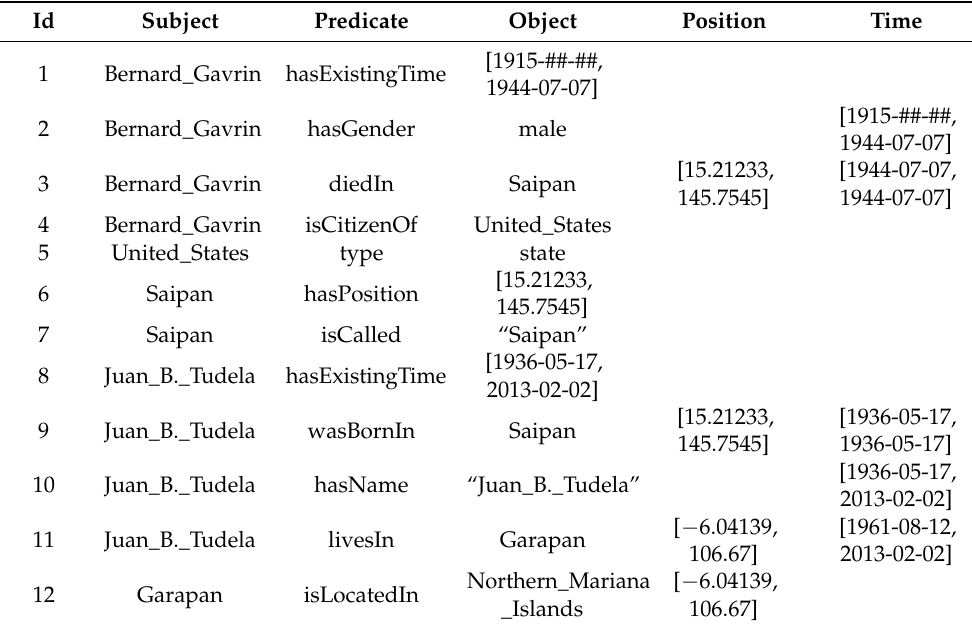
Table 1. Spatiotemporal RDF